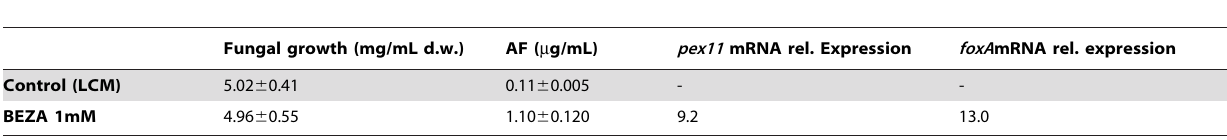
Table 1. Aflatoxin ( m g/mL) synthesis, fungal growth (mg/mL d.w.), pex11 and foxA mRNA relative expression in A. flavus 3357 (WT) grown in basal media (CD) for aflatoxin (AF) synthesis after 7 days at 30 u C.